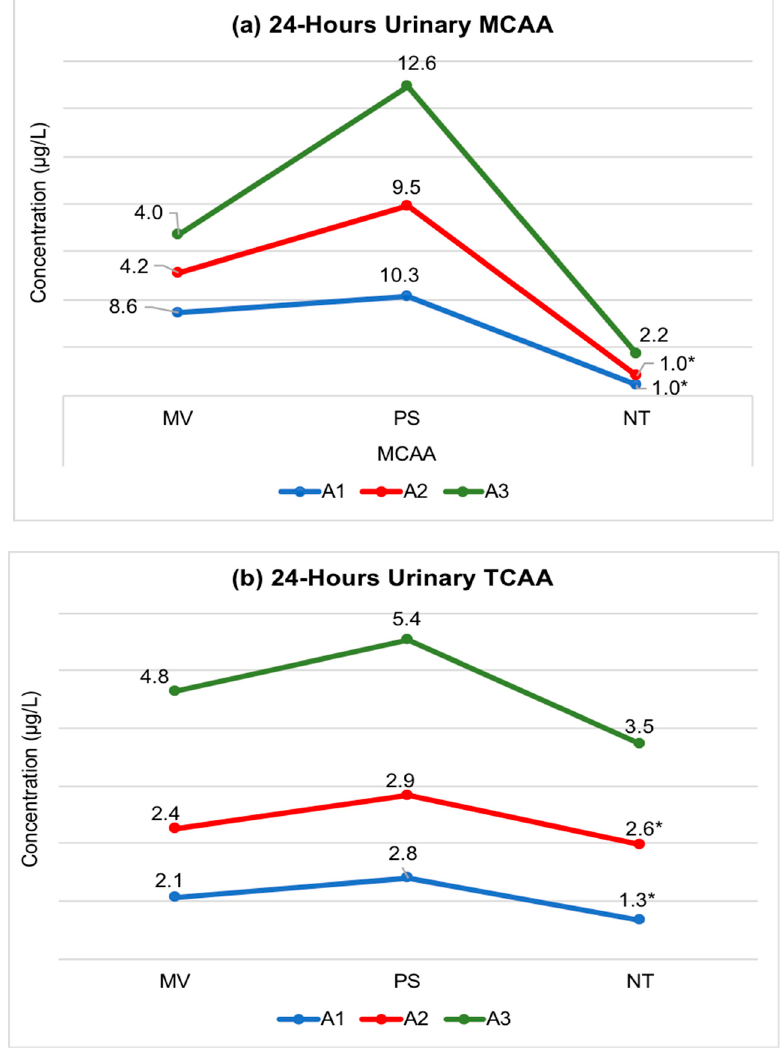
Figure 2. Intra-individual (24-h longitudinal) exposure trend of urinary MCAA and TCAA levels. Legend: Graphs show MCAA (Figure 2a) and TCAA (Figure 2b) concentration change in urinary specimens collected from three participants A1, A2, and A3. Specimens were collected at morning void (MV), post-shower (PS), and nighttime (NT). * represent mean values derived from participant A1 and A2 who provided duplicate NT specimens, while other values are derived based on single specimen analysis. All individual level data are provided in the supporting material Table S3.